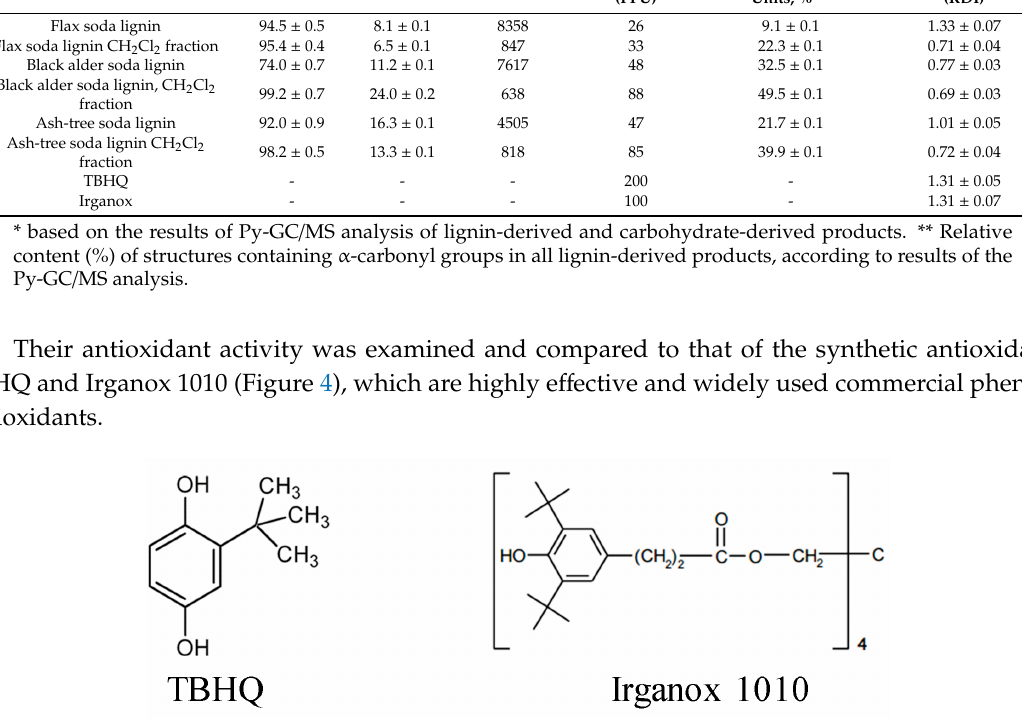
Table 3. Characterization of the lignin samples in terms of their composition, molecular weight distribution, functionality, and antioxidant activity.